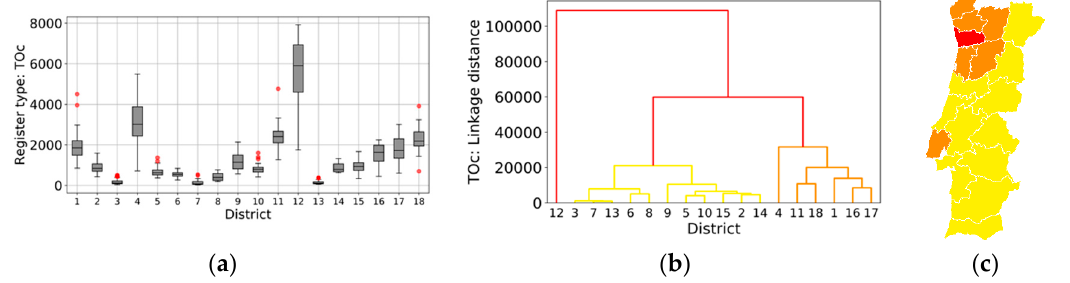
Figure 3. Spatial distribution of Total occurrences (TOc): ( a ) Distribution by district; ( b ) Clusters by annual profile of distribution; ( c ) Clusters in geographic location (cophenetic coefficient: 0.88).